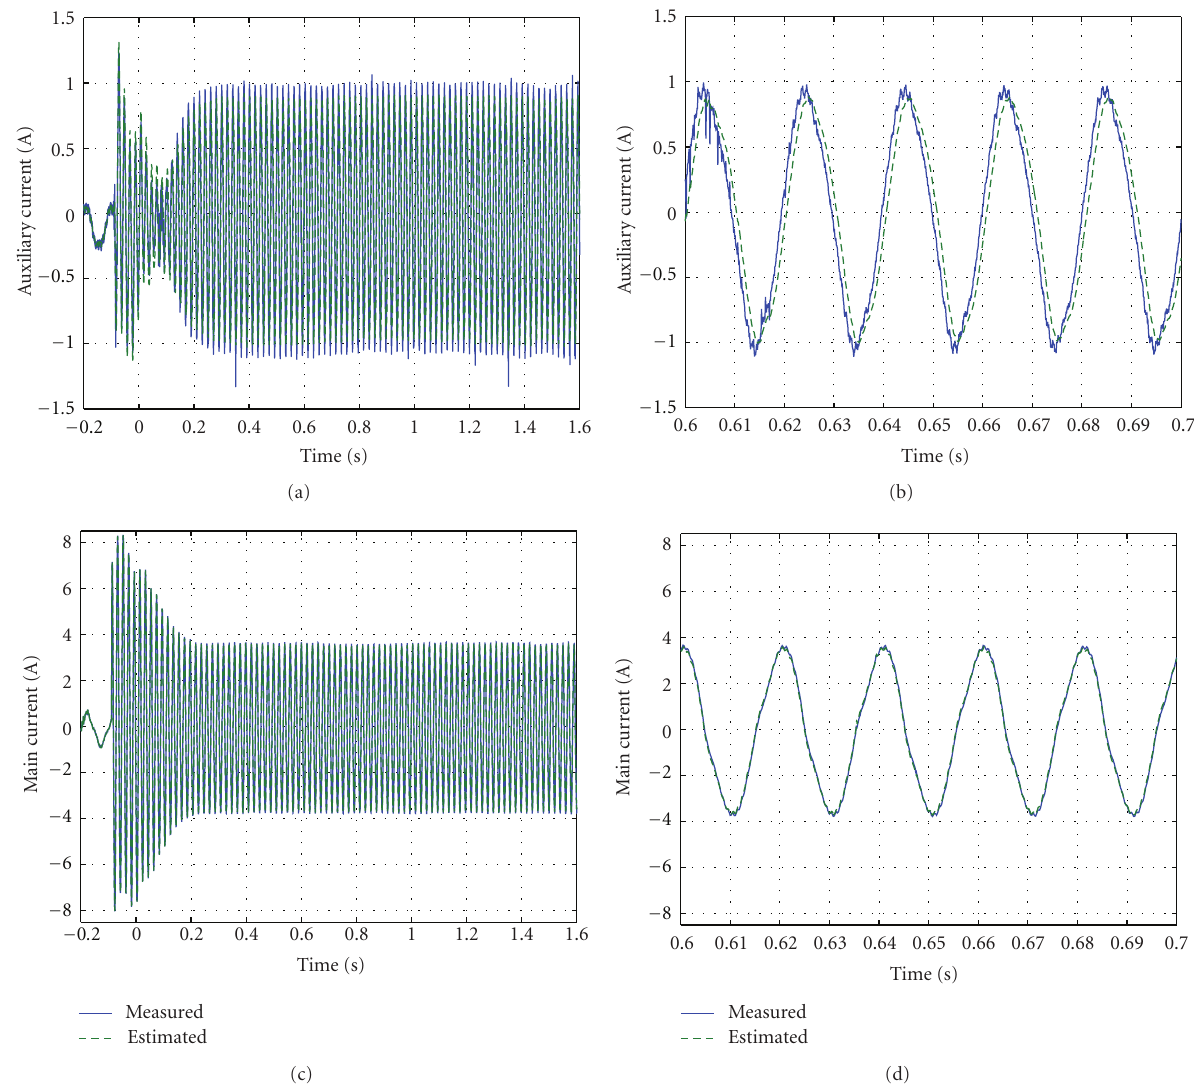
Figure 11: Measured and estimated stator currents of the SPIM during the step from 10 Hz to 50 Hz in the frequency stator (experimental results): (a) auxiliary winding i sα , (b) details of i sα at 50 Hz, (c) main winding i sβ , (d) details of i sβ at 50